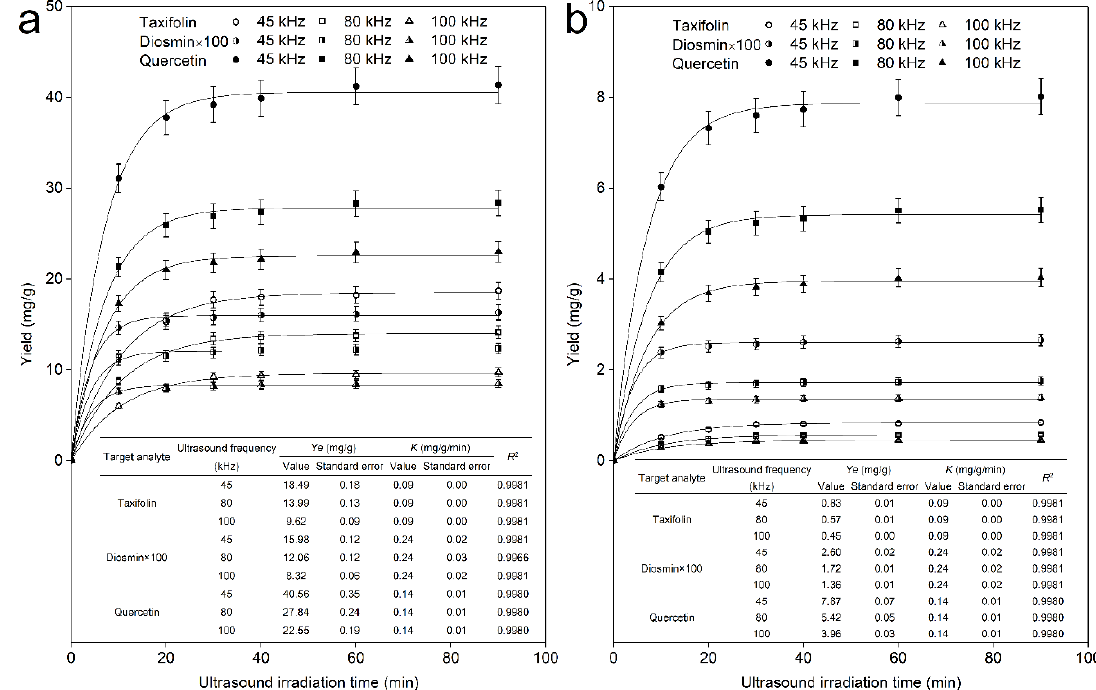
Figure 5. Dynamic curves for taxifolin, diosmin, and quercetin with various ultrasound frequencies (45 kHz, 80 kHz, and 100 kHz) from Abies nephrolepis leaves ( a ) and bark ( b ).